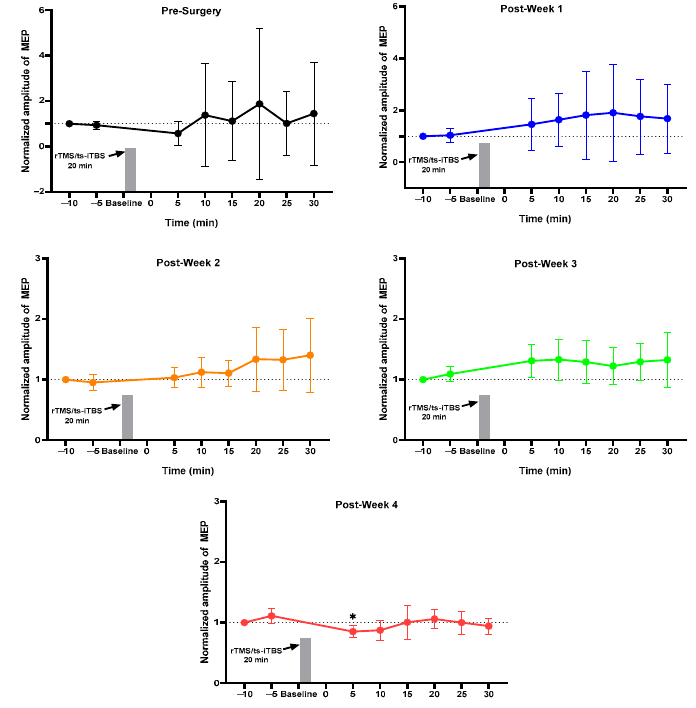
Figure 6. rTMS/ts-iTBS ( n = 5). rTMS/ts-iTBS (20 min); Pre_5 min vs. post_5, 10, 15, 20, 25, and Figure 6. rTMS/ts ‐ iTBS ( n = 5). rTMS/ts ‐ iTBS (20 min); Pre_5 min vs. post_5, 10, 15, 20, 25, and 30 30 min were compared using paired sample t -test; The level of significance was set to p < 0.050 *. min were compared using paired sample t ‐ test; The level of significance was set to p < 0.050 *.